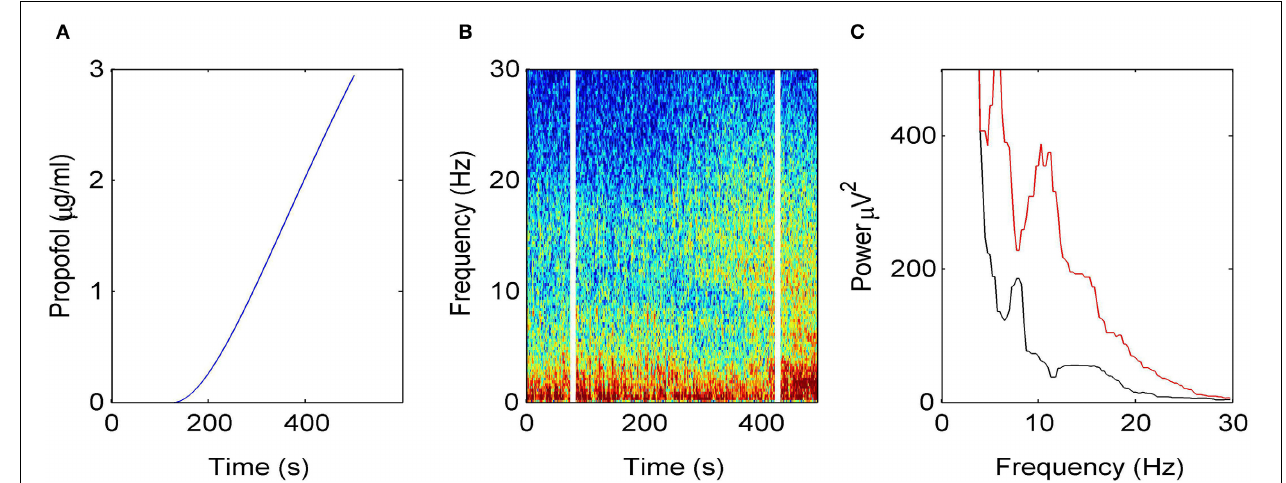
FIGURE 2 | Electroencephalographic data observed under anesthesia sedation in a single subject while increasing the propofol concentration. (A) Blood plasma concentration of propofol with respect to administration time. (B) Spectrogram of frontal EEG power. The